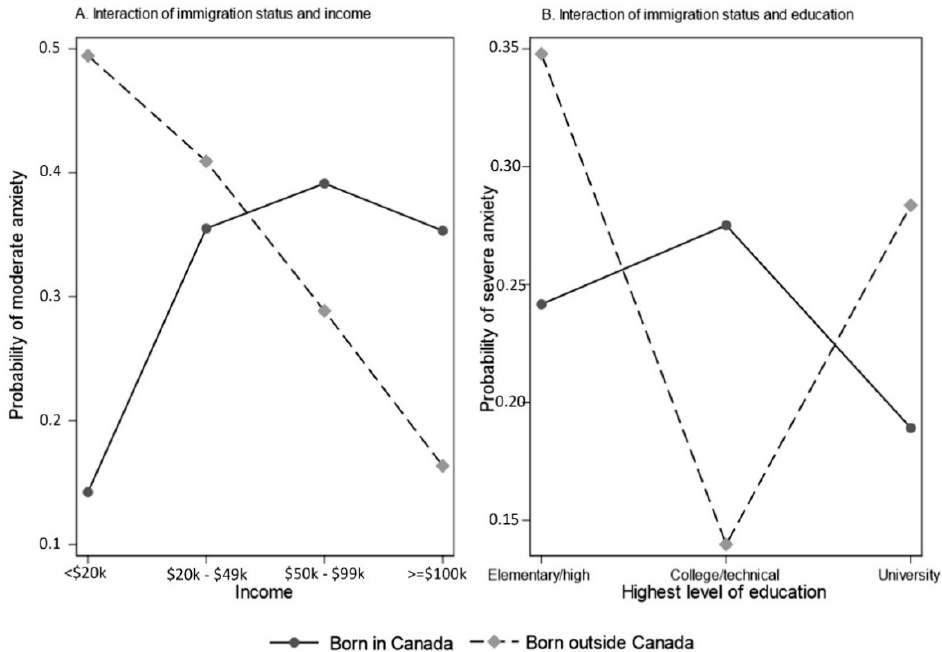
Figure 2. Interaction plots for anxiety: ( A ) moderate anxiety, income effects moderated by immigra- tion status; and ( B ) severe anxiety, education effects moderated by immigration status.